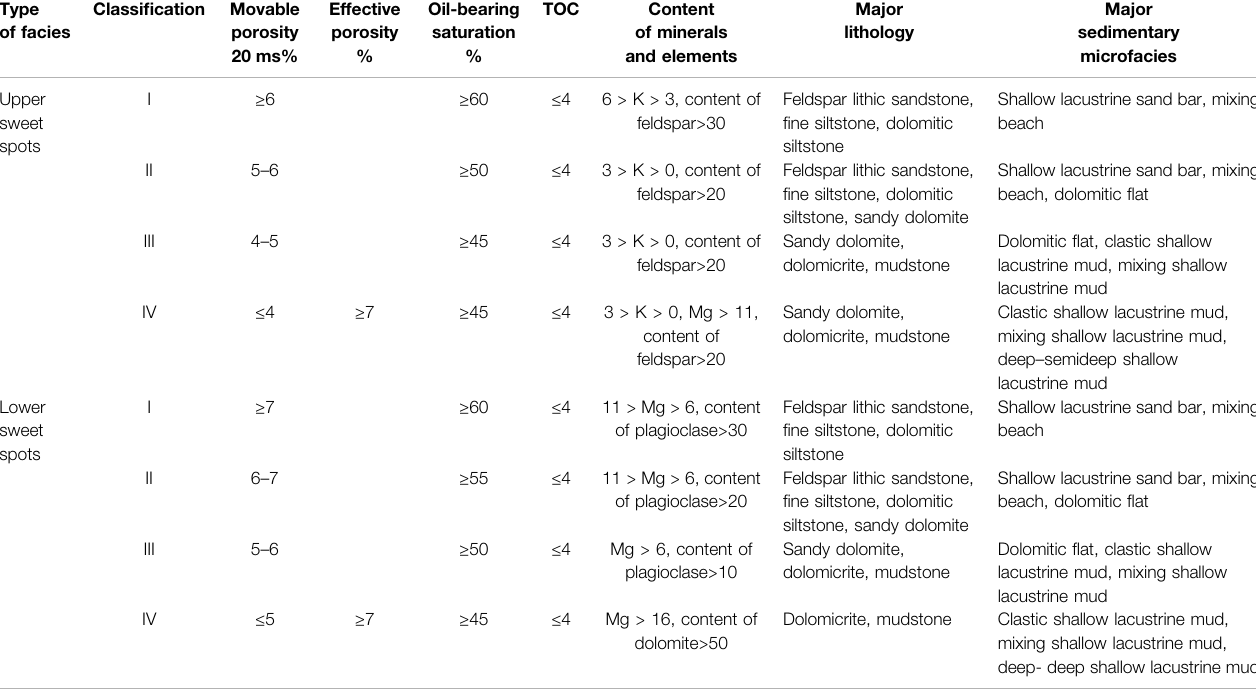
TABLE 2 | Criteria for classi fi cation of sweet spots in the Lucaogou Formation of the Jismar sag. Type Classi fi cation Movable of facies